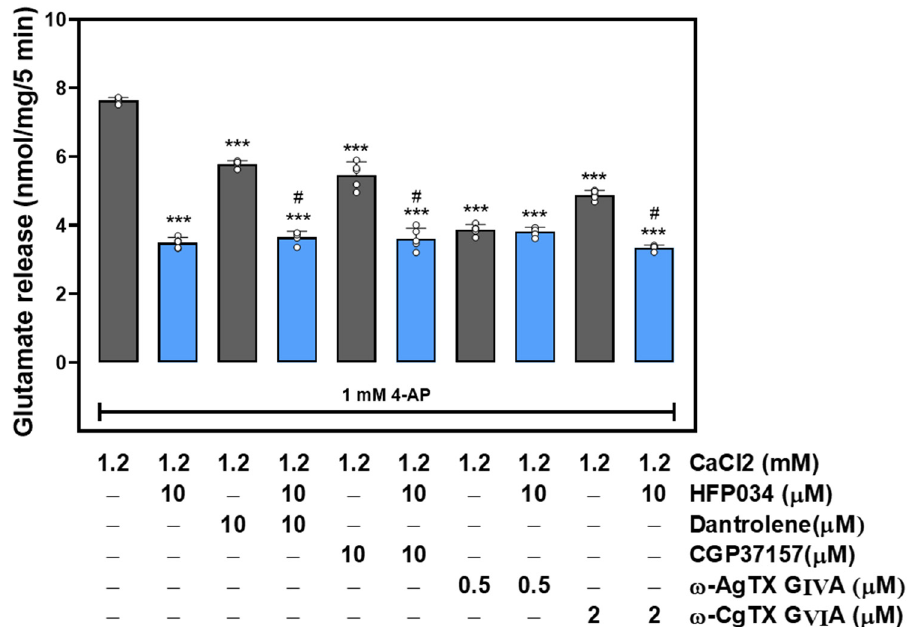
Figure 3. Effect of HFP034 on 4-AP-evoked glutamate release in the presence of N-type Ca 2+ channel blocker ω -CgTX GVIA, P/Q-type Ca 2+ channel blocker ω -AgTX IVA, ryanodine receptor inhibitor dantrolene, or mitochondrial Na + /Ca 2+ exchanger inhibitor CGP37157. HFP034 was added 10 min